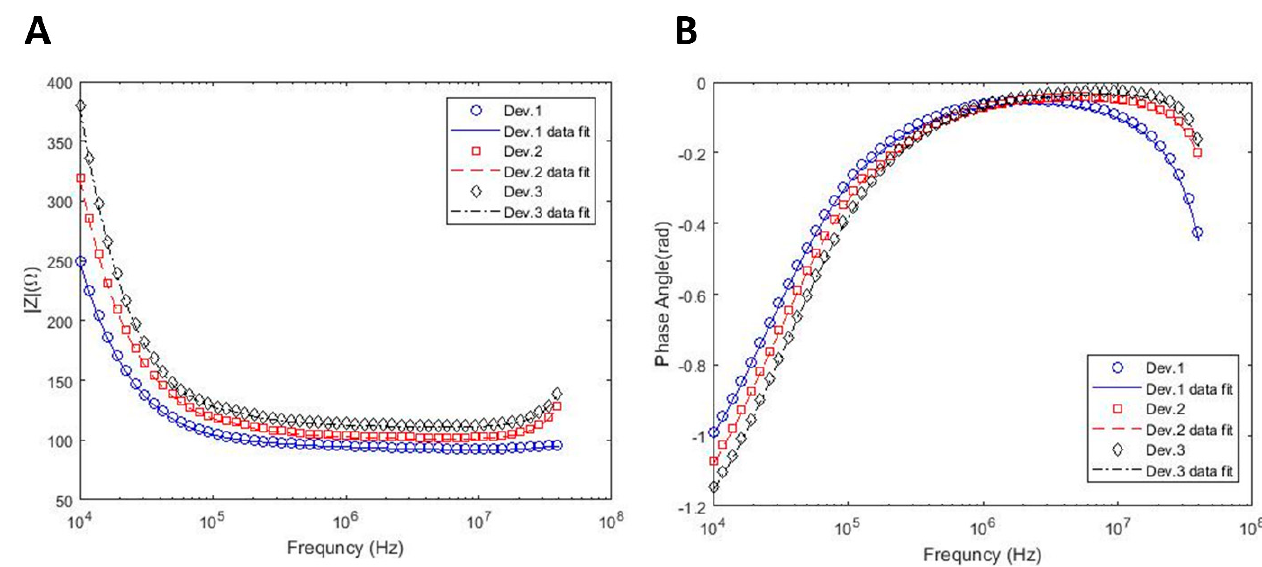
Figure 3. Effect of channel size on the impedance spectra within different frequencies. The widths of channels are 2.1, 1.7, and 1.4 mm for device 1, device 2, and device 3, respectively. ( A ) Impedance magnitude; ( B ) Phase angle.